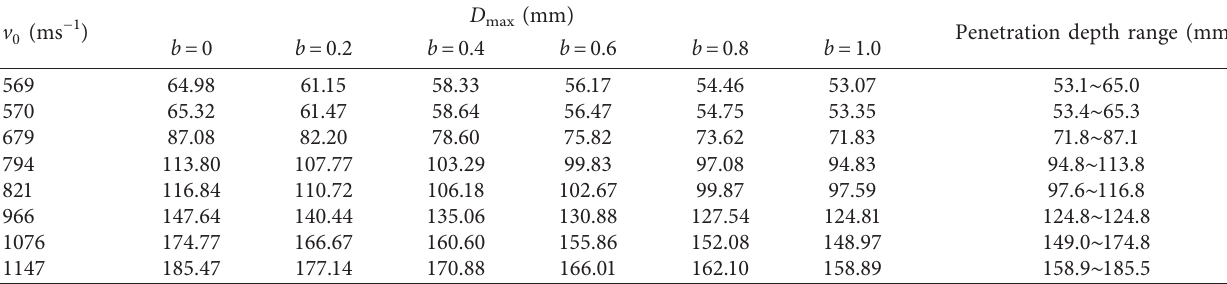
Table 2: Penetration depth ranges.